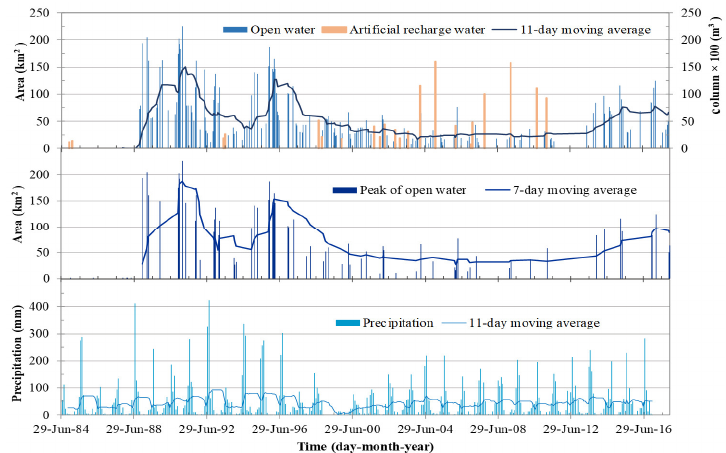
Figure 4. Time variation of open water extents within the wetland range in 2017 for 190 scenes and precipitation from 1984 to 2017. The upper graph is a multi-temporal variation of open water extent (km 2 ) overlaid over the artificial water recharge volume (100 m 3 unit), the middle is the peak of open water extent (km 2 ) each year in November and December, and the bottom is the monthly precipitation in the same year.